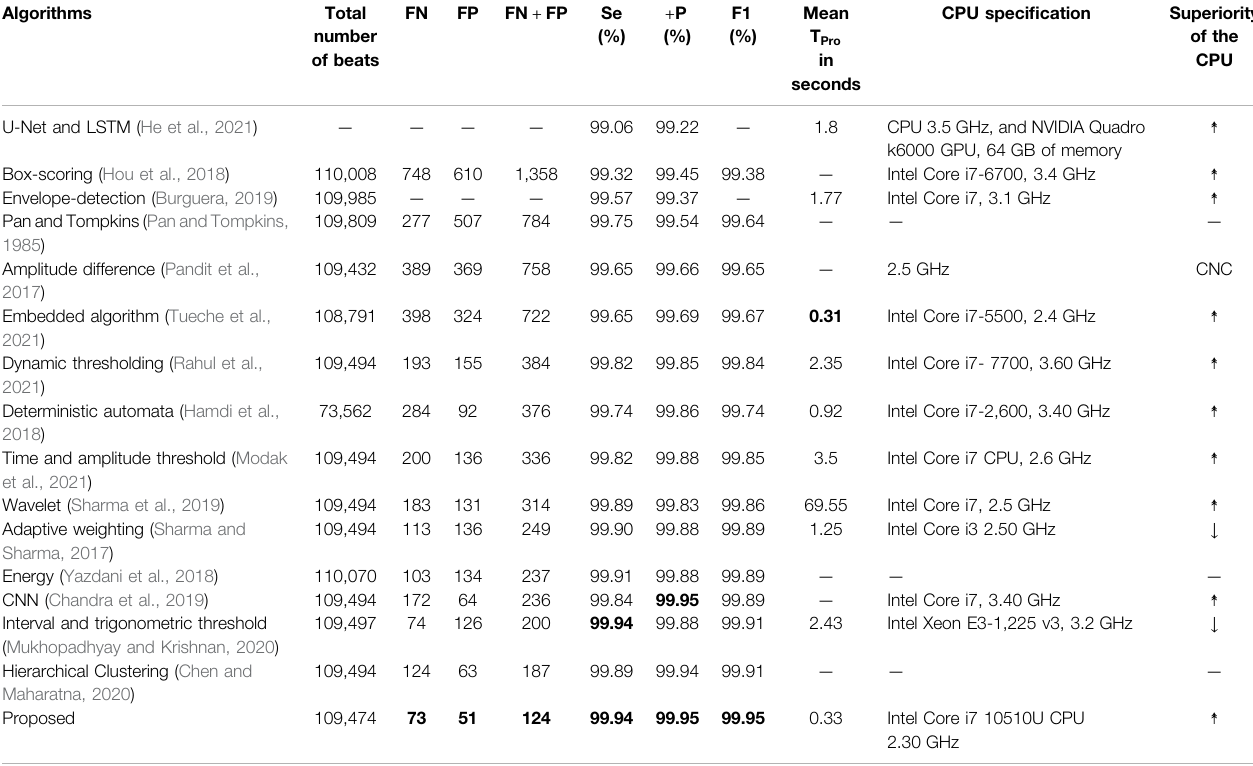
TABLE 6 | Performance comparison of the proposed algorithm with a few other recently developed algorithms on MITDB.